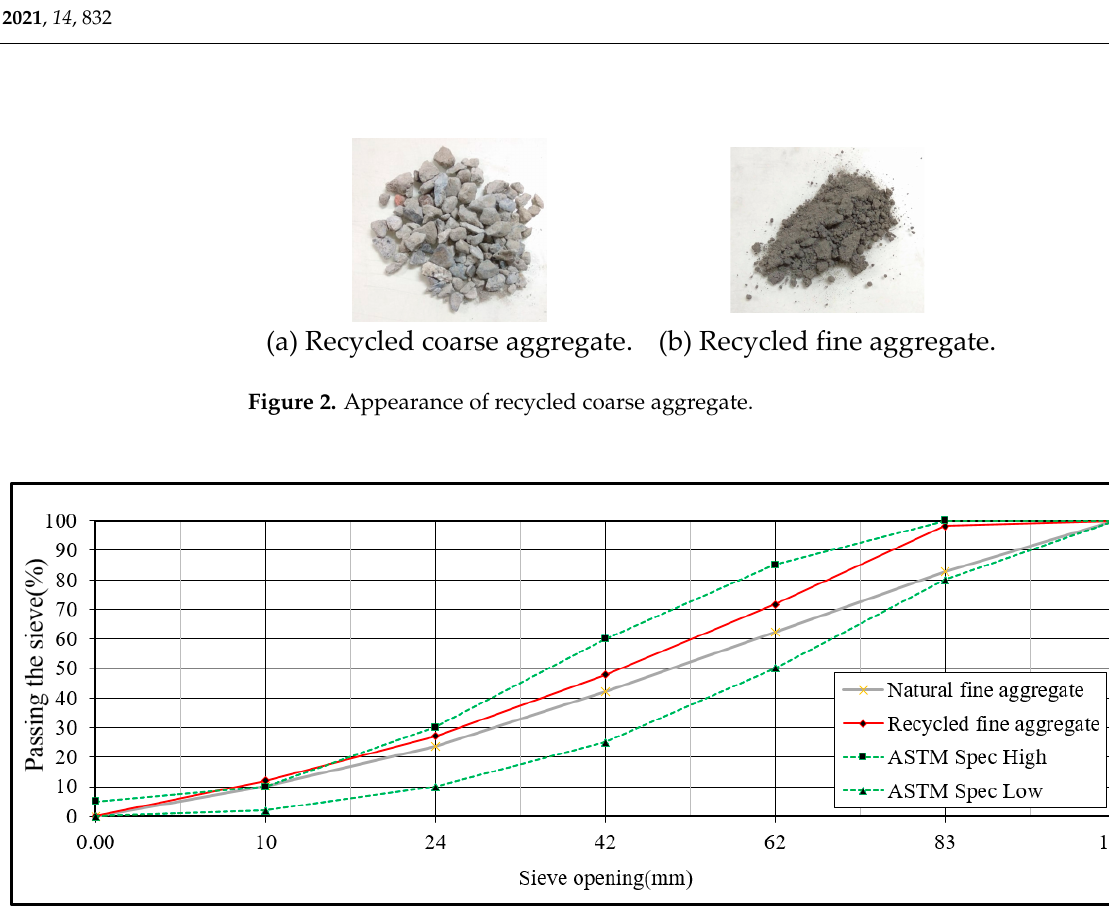
Figure 3. Particle size distribution curve of natural and recycled fine aggregate.